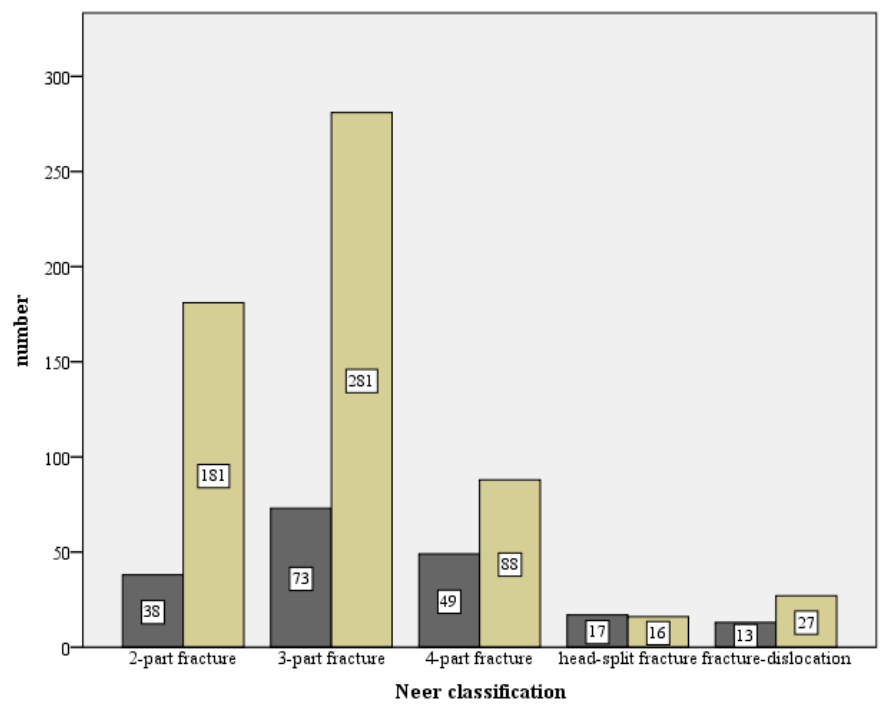
Figure 25. Comparison of the number with complications (dark) and without complications (light) in relation to the respective fracture type, based on the Neer classification (X-axis: Neer classification, Y-axis: number).